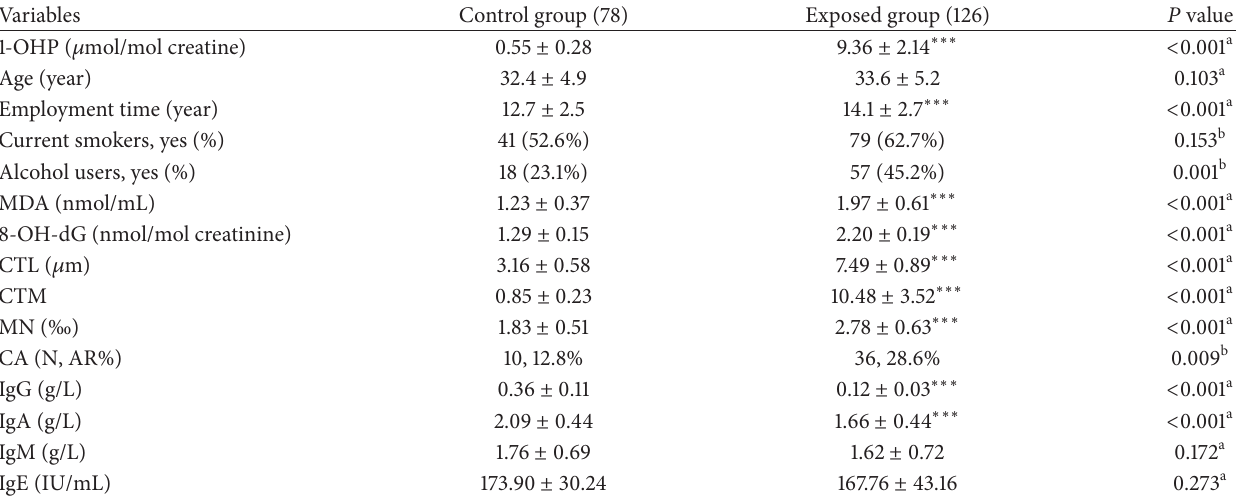
Table 1: Demographic characteristics of workers in the control and exposed groups.